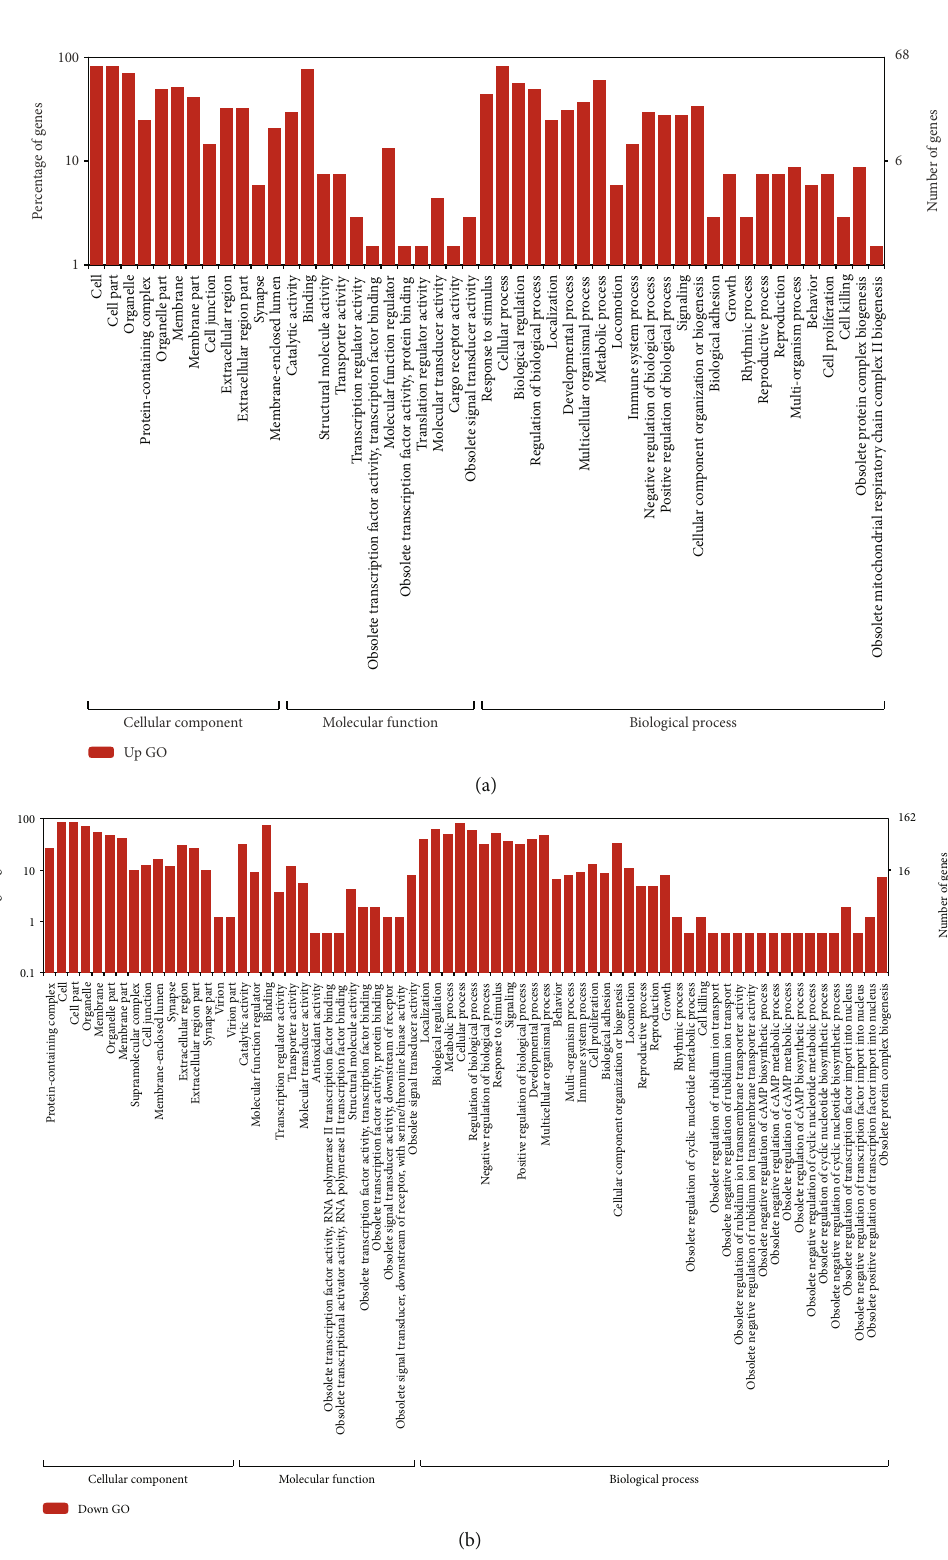
Figure 3: GO classi fi cation analysis of upregulated (a) and downregulated (b)